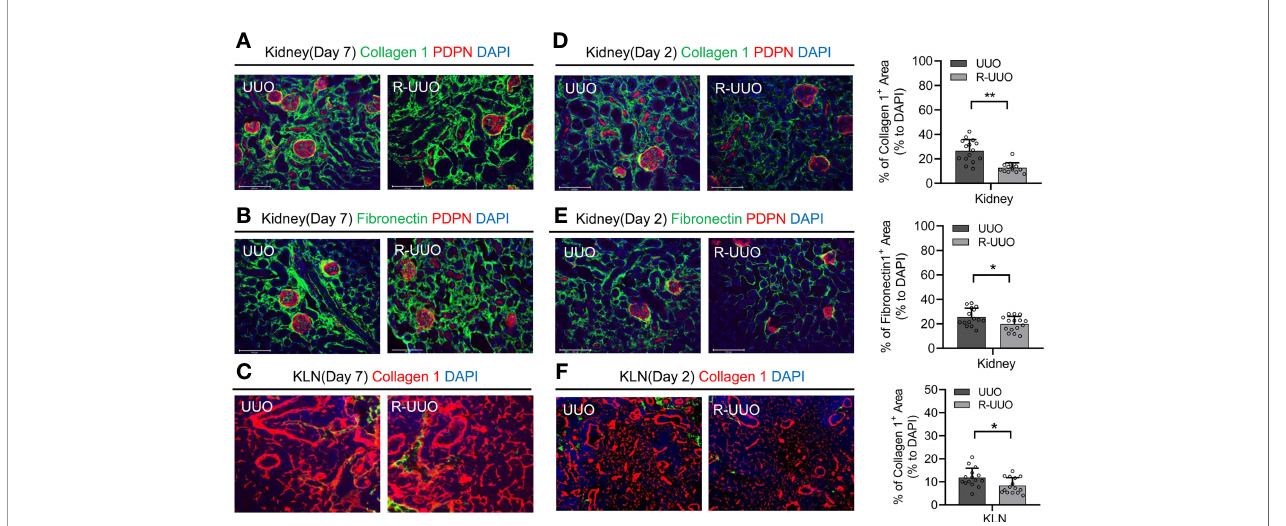
FIGURE 4 | Release of UUO (R-UUO) at Day 2 halts fi brosis in the kidney and KLN but has no effect at Day 7. (A, B) Fluorescence micrographs of collagen 1 fi bers (green) and fi bronectin fi bers (green) reveal no difference in fi brosis between the UUO and R-UUO kidneys at Day 21 following release of ureteral ligation at Day 7 (PDPN glomerular stain, red; DAPI nuclear stain, blue). (C) Fluorescence micrographs of collagen 1 fi bers (red) demonstrate no difference in fi brosis between the UUO and R-UUO KLNs at Day 21 following release of ureteral ligation at Day 7 (DAPI nuclear stain, blue). (D, E) Fluorescence micrographs and semiquantitative analysis show signi fi cantly higher density of (D) collagen 1 fi bers (green) and (E) fi bronectin fi bers (green) normalized to DAPI-stained area (blue) in UUO kidneys than R-UUO kidneys at Day 21 following release of ureteral ligation at Day 2 (PDPN glomerular stain, red) (n=15 random microscopic fi elds of sections from 3 mice). (F) Fluorescence micrographs and semiquantitative analysis show signi fi cantly higher density of collagen 1 fi bers (green) normalized to DAPI-stained area (blue) in UUO KLNs than R-UUO KLNs at Day 21 following release of ureteral ligation at Day 2 (n=15 random microscopic fi elds of sections from 3 mice). Data represented by means ± SEM. *p < 0.05, **p <